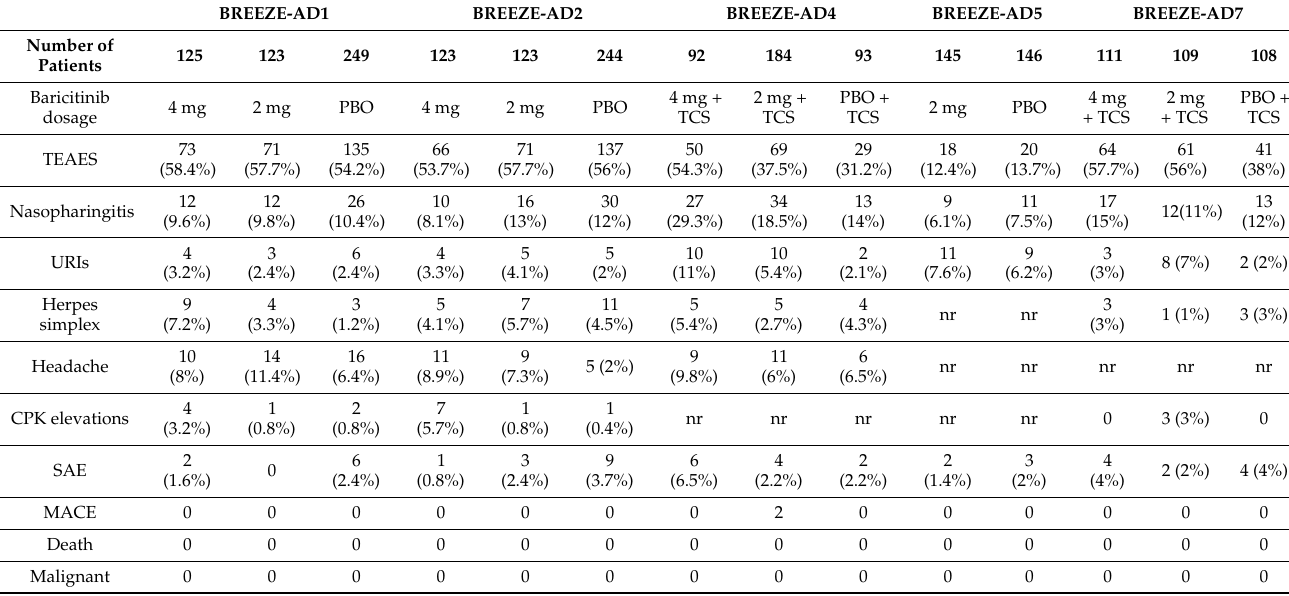
Table 3. Summary of adverse events from BREEZE-AD1, AD2, AD4, AD5, and AD7 phase III studies currently available on clinicaltrials.gov. (accessed on 2 November